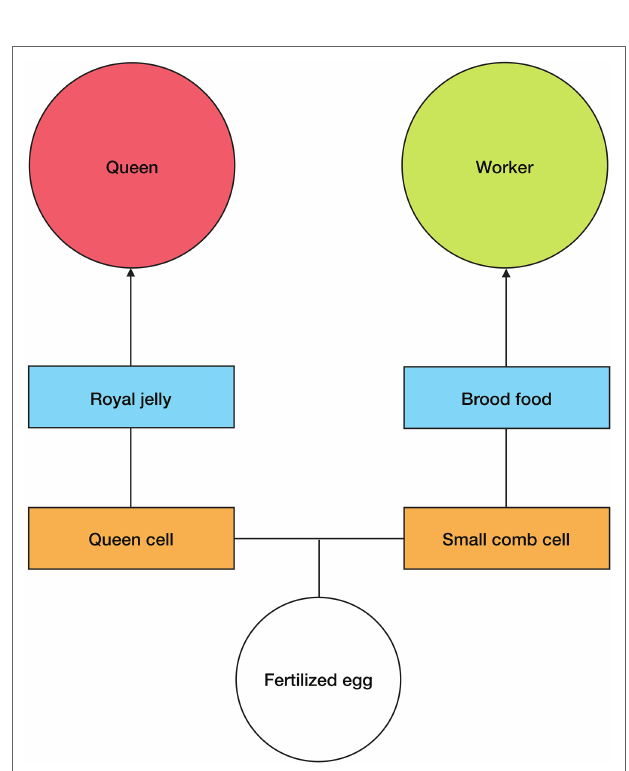
FIGURE 2 | Queen/worker production. Any fertilized egg can develop into a queen or worker in A. mellifera . The type of comb cell, orange squares , and diet, blue squares , determine the development of larvae. Large queen cells and royal jelly cause larvae from fertilized eggs to develop into queens, whereas small comb cells and brood food cause equivalent larvae to develop into workers. Royal jelly induces an epigenetic change within the larvae. The size of the comb cell constrains larval growth. See text for more